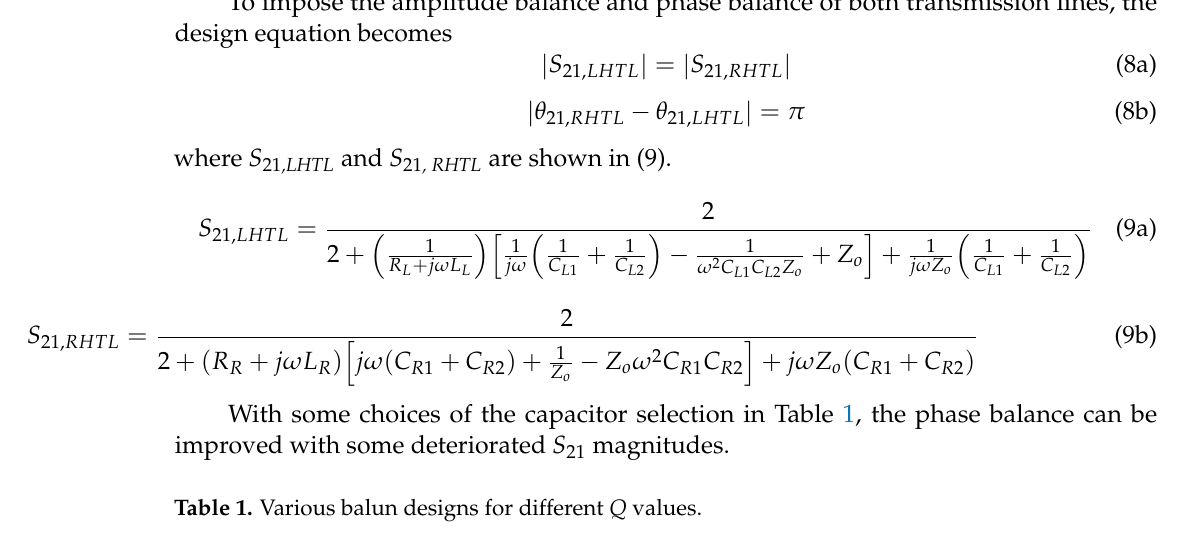
Table 1. Various balun designs for different Q values.